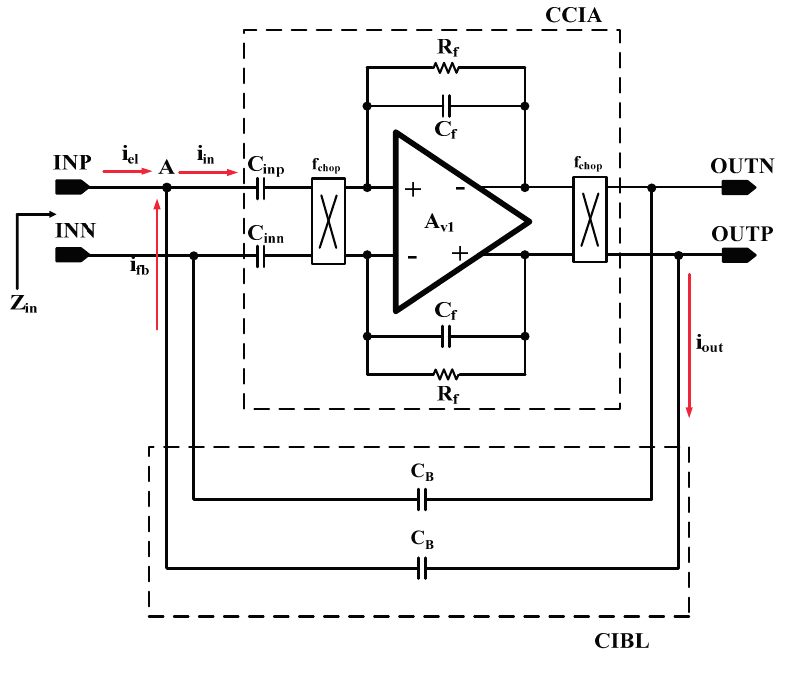
Figure 11. Schematic of the